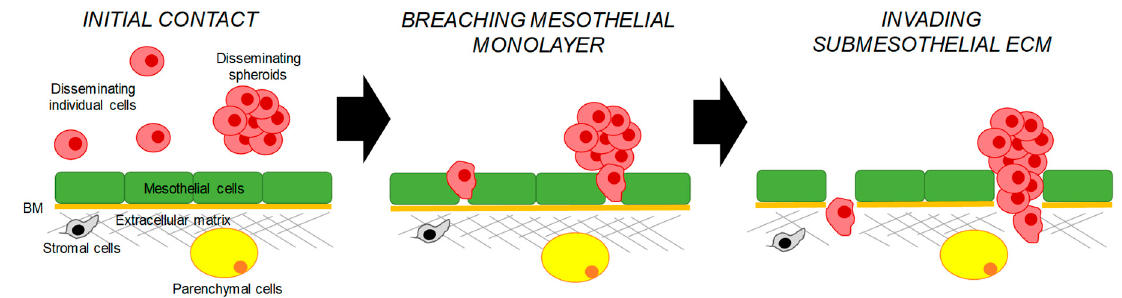
Figure 1. A scheme of the peritoneal metastasis through the transcoelomic route. Disseminating epithelial ovarian carcinoma (EOC) cells and spheroids are shown in mauve, mesothelial cells are shown in green, the basement membrane is shown in orange, stromal cells are shown in grey, parenchymal cells are shown in yellow, and the extracellular matrix is shown in grey.